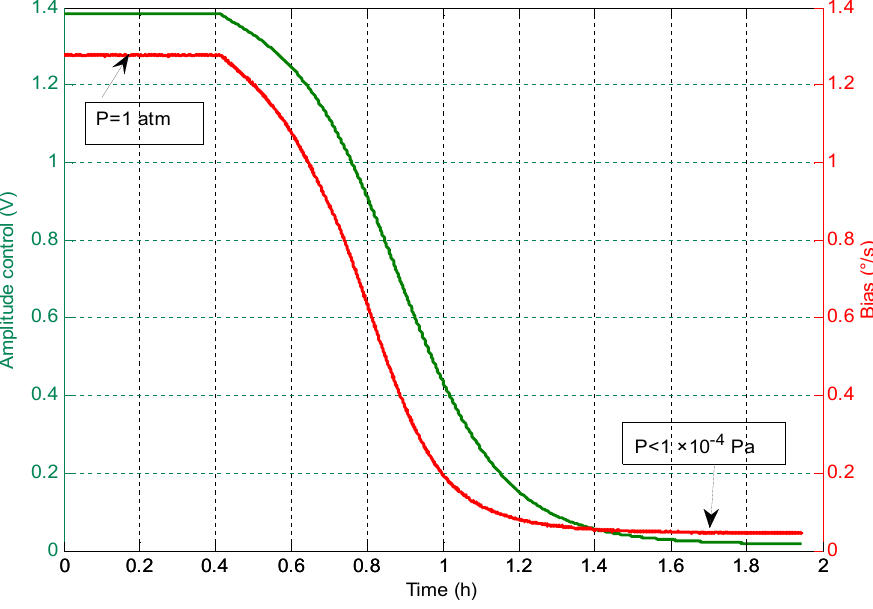
Figure 5. Measured bias drift vs. drive